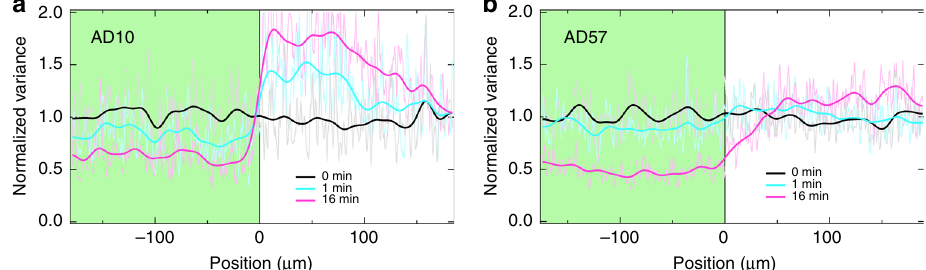
Fig. 4 Effect of stopping distance. Response to a step illumination pattern (left bright, right dark) projected at time t = 0 by two strains starting from initially uniformly swimming cells. Faint lines show the normalised variance (a measure of cell density) pro fi le, whereas bold lines show numerically smoothed pro fi les. a AD10 with τ off ≲ 1 s and b AD57 with τ off ≳ 1 min (corresponding images in Supplementary Fig.